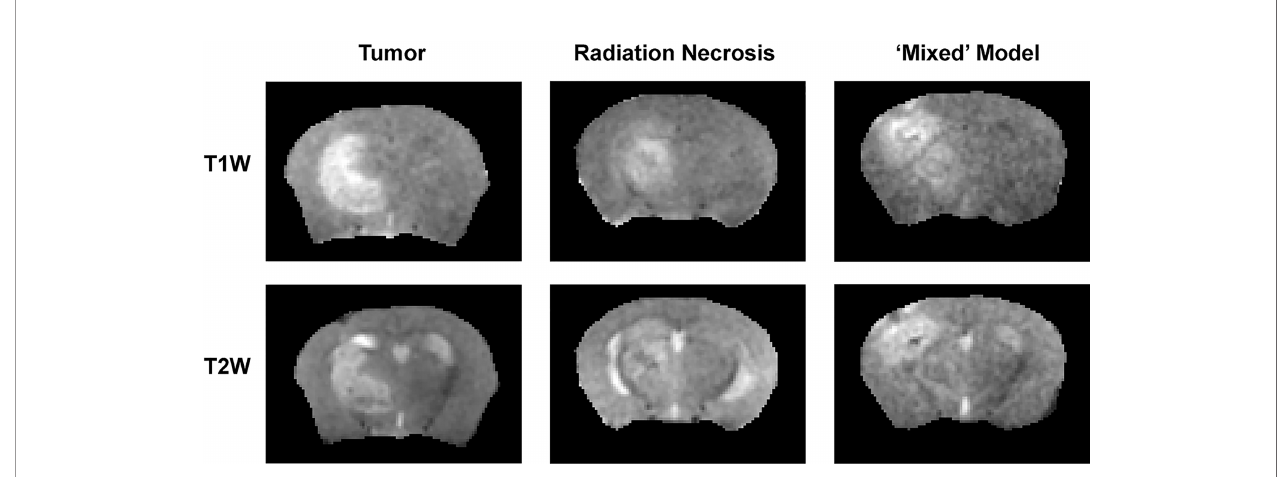
FIGURE 3 | (top) T1-weighted and (bottom) T2-weighted images, both acquired post contrast, of: (left) pure tumor; (middle) pure RN; and (right) the